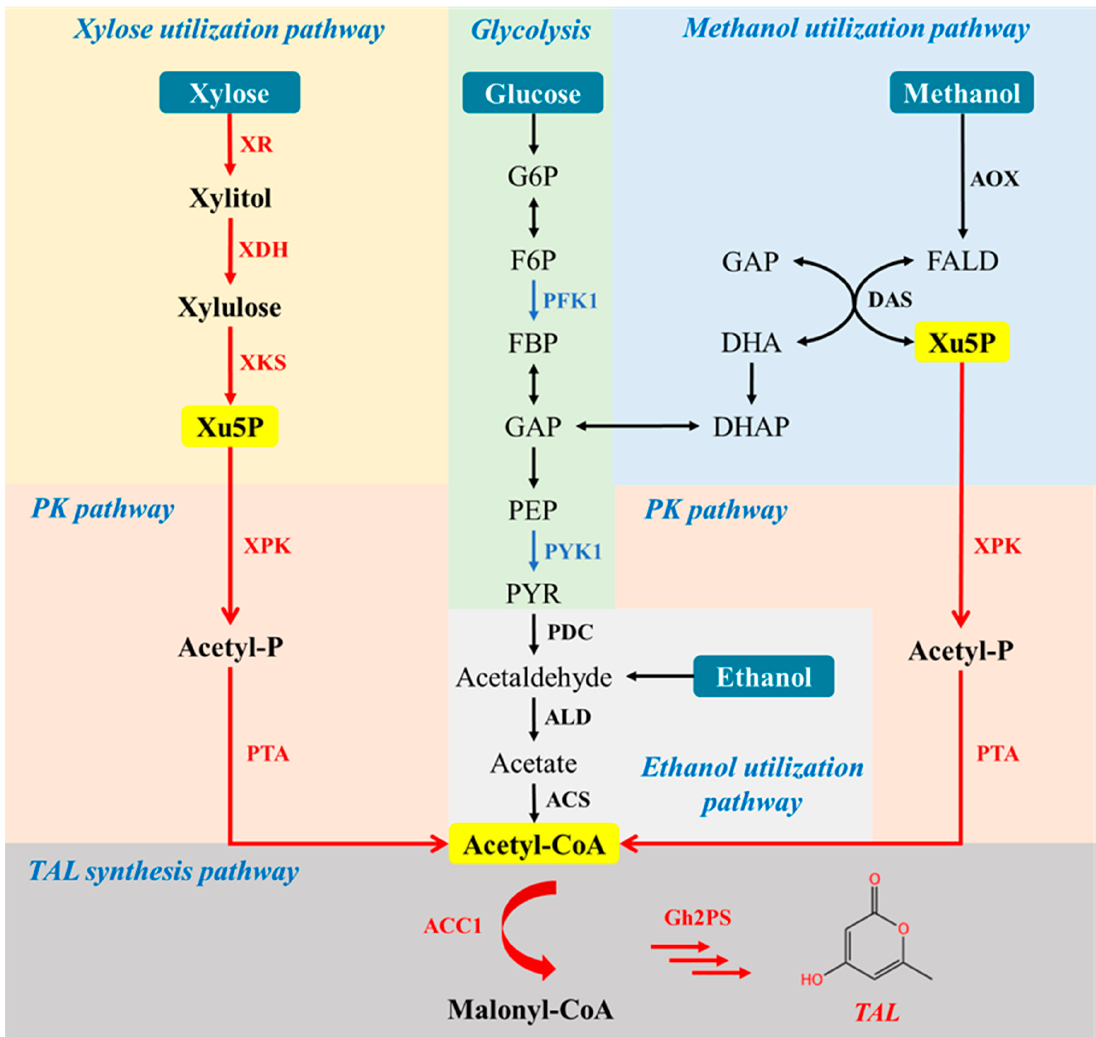
Figure 1. Metabolic pathway engineering for TAL synthesis in P. pastoris . Heterologous genes and deleted genes are presented in red and blue, respectively. PFK1, phosphofructokinase; PYK1, pyruvate kinase; XR, xylose reductase; XDH, xylitol dehydrogenase; XKS, xylulokinase; xPK, xylulose-5-phosphate specific phosphoketolase; PTA, phosphotransacetylase; ACC1, acetyl-CoA-carboxylase; Gh2PS, 2-pyrone synthase; G6P, glucose-6-phosphate; GL6P, gluconolactone-6-phosphate; 6PG, gluconate-6-phosphate; Ru5P, ribulose-5-phosphate; Xu5P, xylulose-5-phosphate; S7P, sedoheptulose-7-phosphate; GAP, glyceraldehyde-3-phosphate; F6P, fructose-6-phosphate; E4P, erythrose-4-phosphate; FBP, D-fructose-1,6-diphosphate; PEP, phosphoenolpyruvate; PYR, pyruvate; DHA, dihydroxyacetone; DHAP, dihydroxyacetone phosphate; FALD, formaldehyde; Acetyl-P, acetyl-phosphate; TAL, triacetic acid lactone.